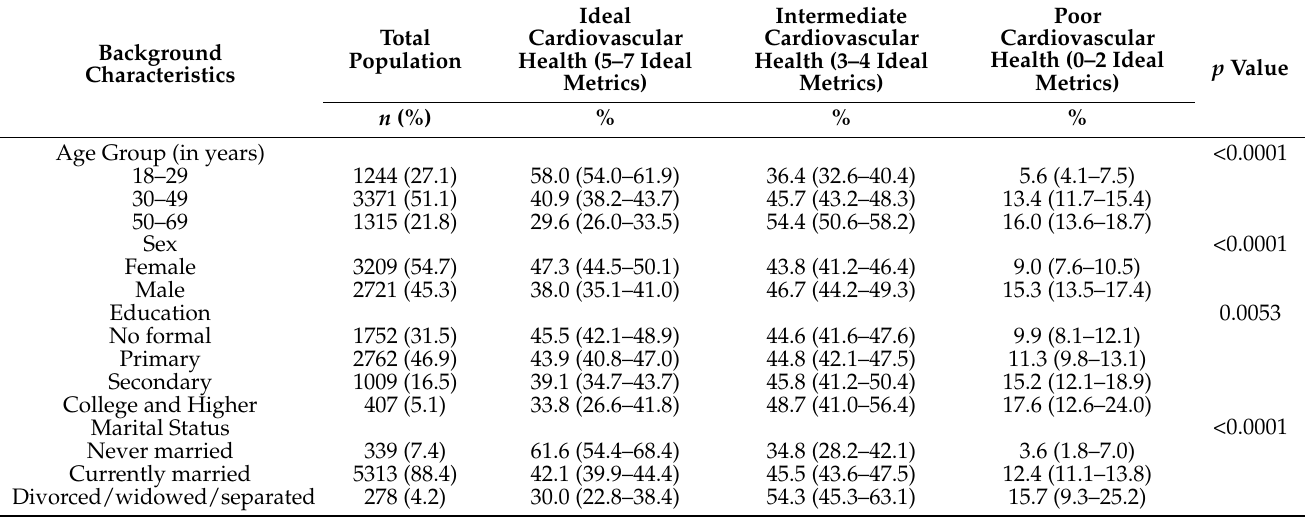
Table 1. Background characteristics of the participants according to cardiovascular health metrics ( N =